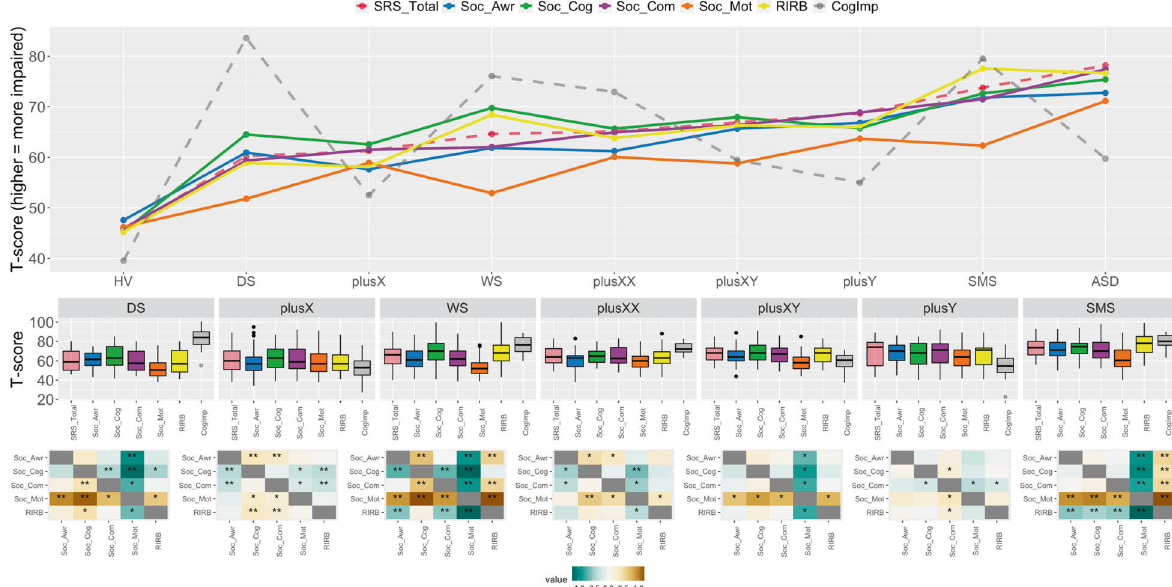
Fig. 3 Autism-related trait (ART) scores for different gene dosage disorders (GDDs). Top panel: Point-line graph showing score pro fi les for each ART across GDDs. Colored solid lines encode ARTs. Cognitive impairment scores are shown as a reference (dashed gray). Middle panel : Boxplots for each GDD showing score distributions for each ART. Bottom panel : Heatmaps for each GDD showing Cohen ’ s d effect sizes for all pairwise ART comparisons (column group vs. row group). Asterisks denote statistically signi fi cant comparisons (*nominal p < 0.05, **surviving Bonferroni correction for multiple Our fi ndings carry implications for both basic and clinical